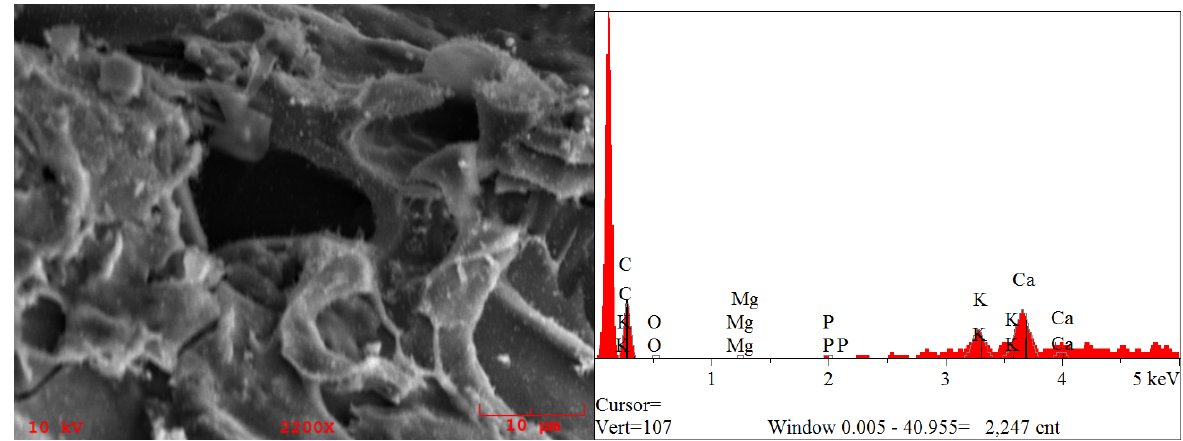
Figure 12. Surface area analysis from inner wood biochar (Elements from left to right K, C, O, Mg, P, K, Ca).